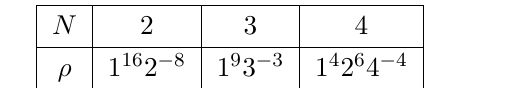
ja j = 0. The negative j